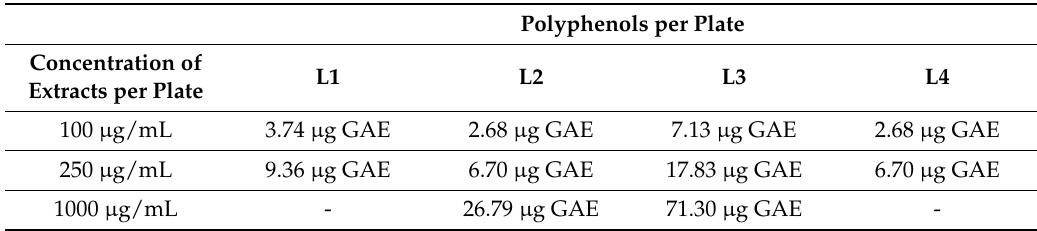
Figure 2. Thermal stress resistances in worms grown in the absence (control) and presence of different concentrations of the pomace extracts. The results are expressed as the percentage of surviving worms after being subjected to thermal stress (35 °C, 8 h) at the 5th day (left side) and 12th day (right side) of adulthood. Three independent experiments were carried out with a minimum of 100 animals per assay. The results are presented as the mean values ± SEM ( n = 3). Statistical significance was calculated using the Chi Square Test. Different letters in bars indicate significant differences ( p < 0.05). Table 3. Amount of phenolic compound per plate for different concentrations of each tested samples estimated from their total polyphenol values determined by the Folin–Ciocalteu.